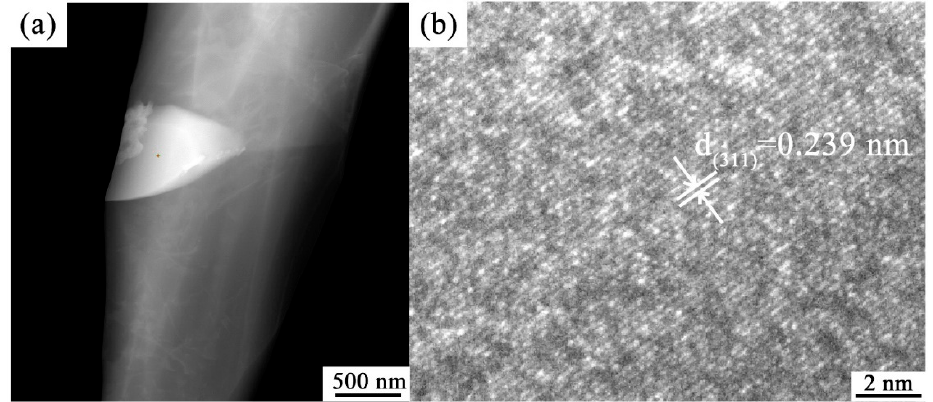
Figure 11. SEM image ( a ) and EDS images ( b – d ) of modi fi ed Al–20Si alloy.